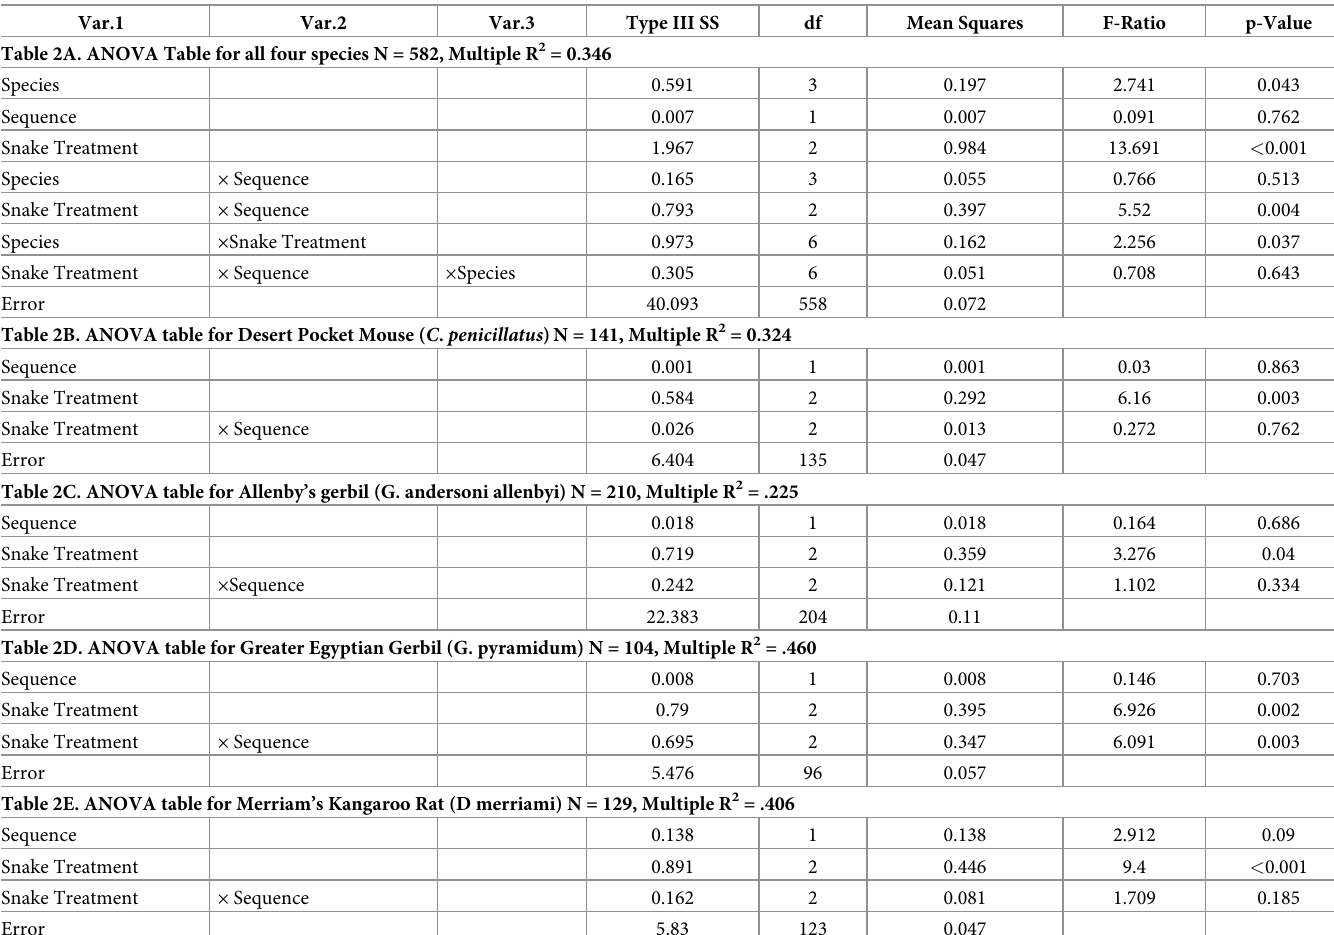
Table 2. ANOVA Tables for General Linear Models for all species combined (A) and each species separately (B-E). Var.1 Table 2A. ANOVA Table for all four species N = 582, Multiple R 2 = 0.346 Species